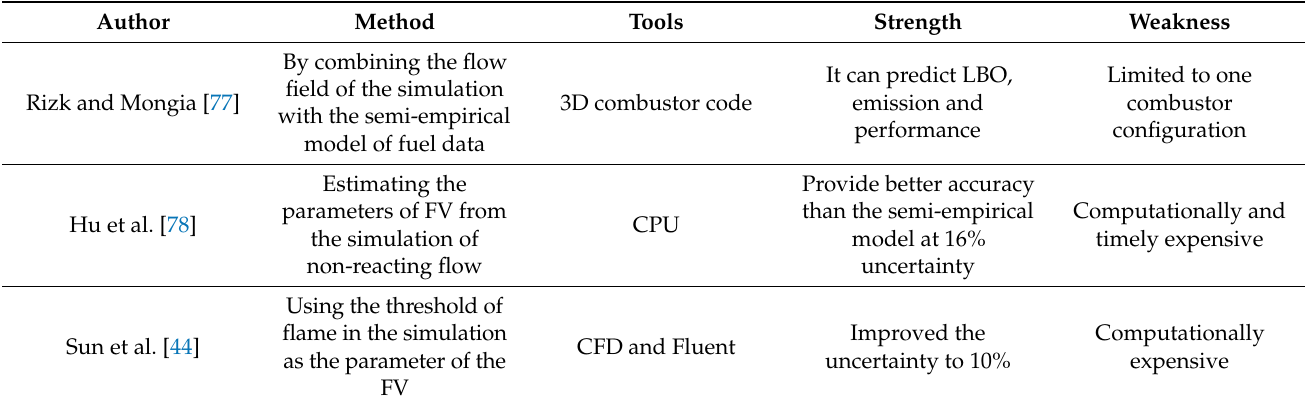
Table 3. Summary of the hybrid